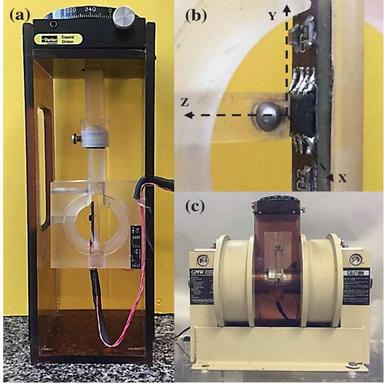
(a) Final assembly of the acrylic structure, including the part that serves as the support for the micrometer and the base on which the sensors are mounted on the acrylic piece. (b) Acrylic piece connected to the cylindrical arm and sample holder with a nickel sphere positioned exactly above the AD22151 Hall sensor, which was installed on the circuit board; the axes indicate the x-, y- and z-directions. (c) Assembled magnetometer.